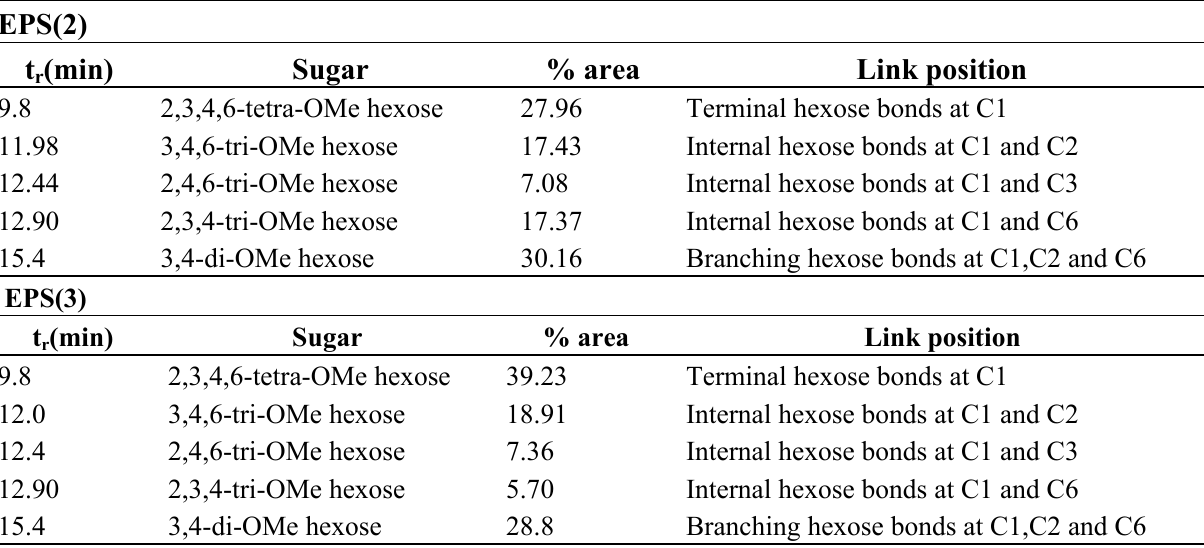
Table 1. GC-MS of EPS(2) and EPS(3) from tomato cells of Lycopersicon esculentum var. San Marzano